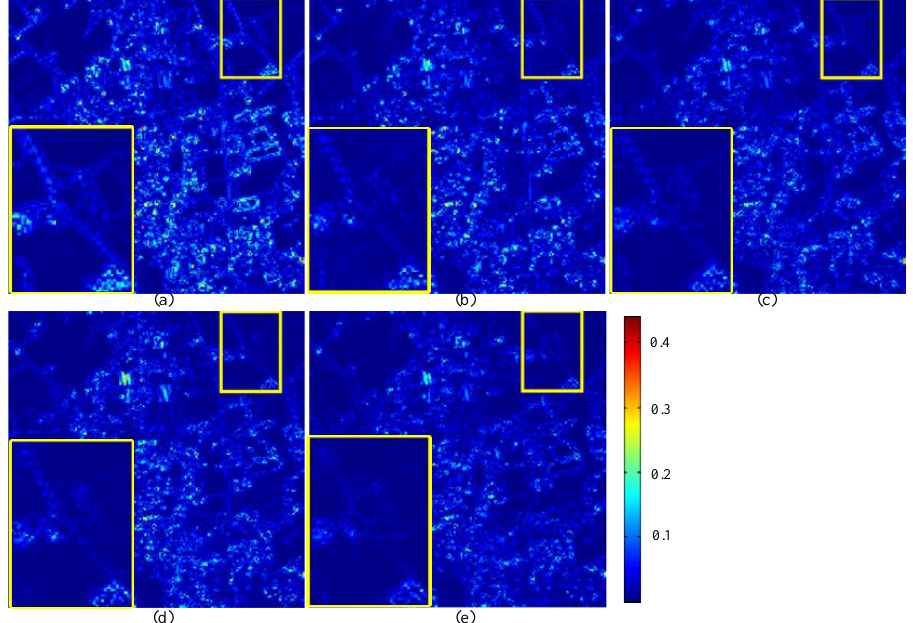
Figure 9. The residual maps on Chikusei by an upscaling factor of two. ( a ) Bicubic result, (b) SSG result [27], ( c ) SRCNN result [40], ( d ) 3D-CNN result [32], and ( e ) the proposed MW-3D-CNN result. The residual maps are displayed by scaling to the minimum and maximum errors.